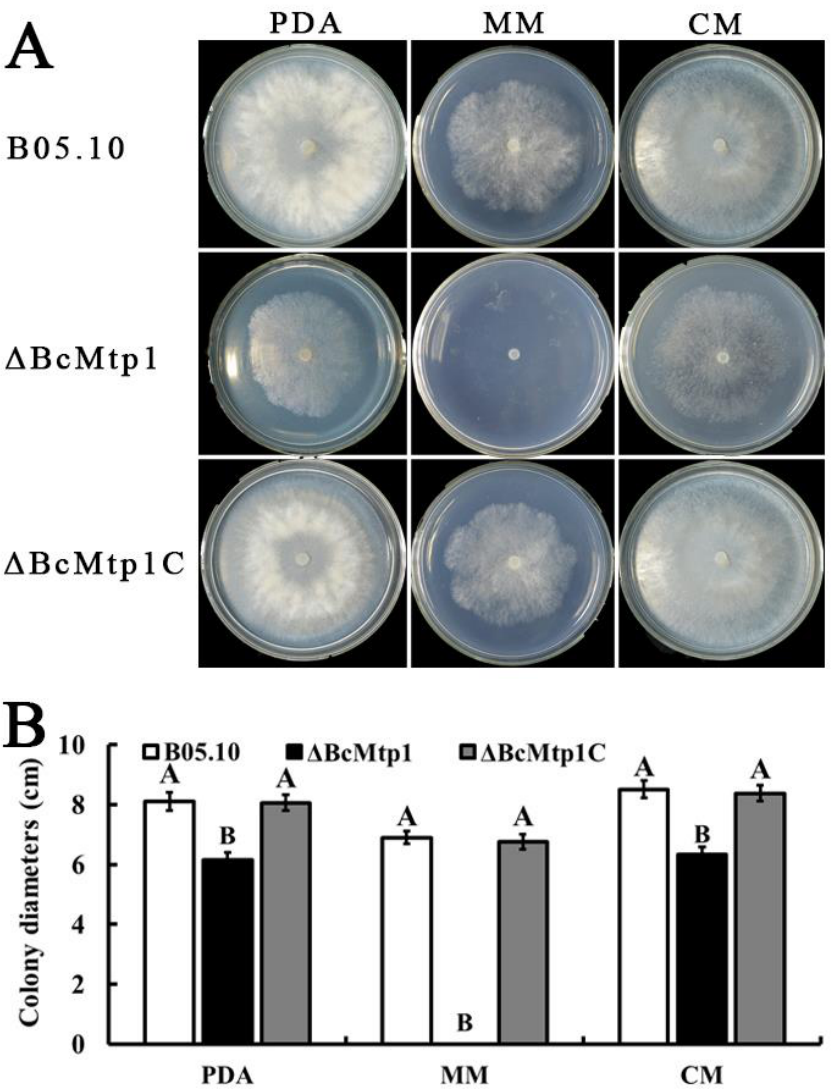
Figure 1. Effect of BcMtp1 deletion on mycelia growth. ( A ) The wild-type strain B05.10, the BcMtp1 deletion mutant ΔBcMtp1, and the complemented strain ΔBcMtp1C were grown on solid media [potato dextrose agar (PDA), complete medium (CM), and minimal medium (MM)] for 3 d at 25 °C, in the dark. ( B ) The colony diameter of B05.10, ΔBcMtp1 , and ΔBcMtp1C on PDA, CM, and MM for 3 d at 25 °C, in the dark. Bars denote standard errors from three repeated experiments.